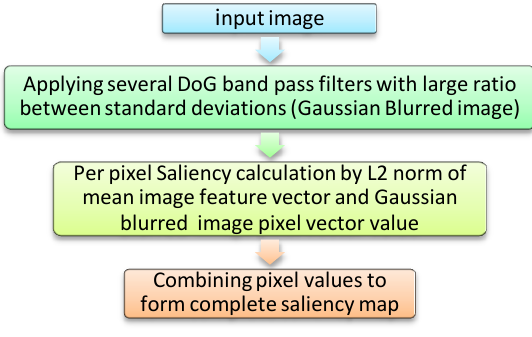
Figure 4. Work Flow diagram of Frequency-tuned Saliency